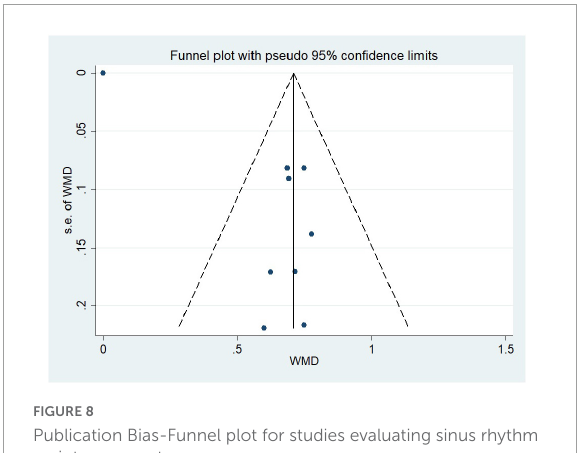
FIGURE8 Publication Bias-Funnel plot for studies evaluating sinus rhythm maintenance